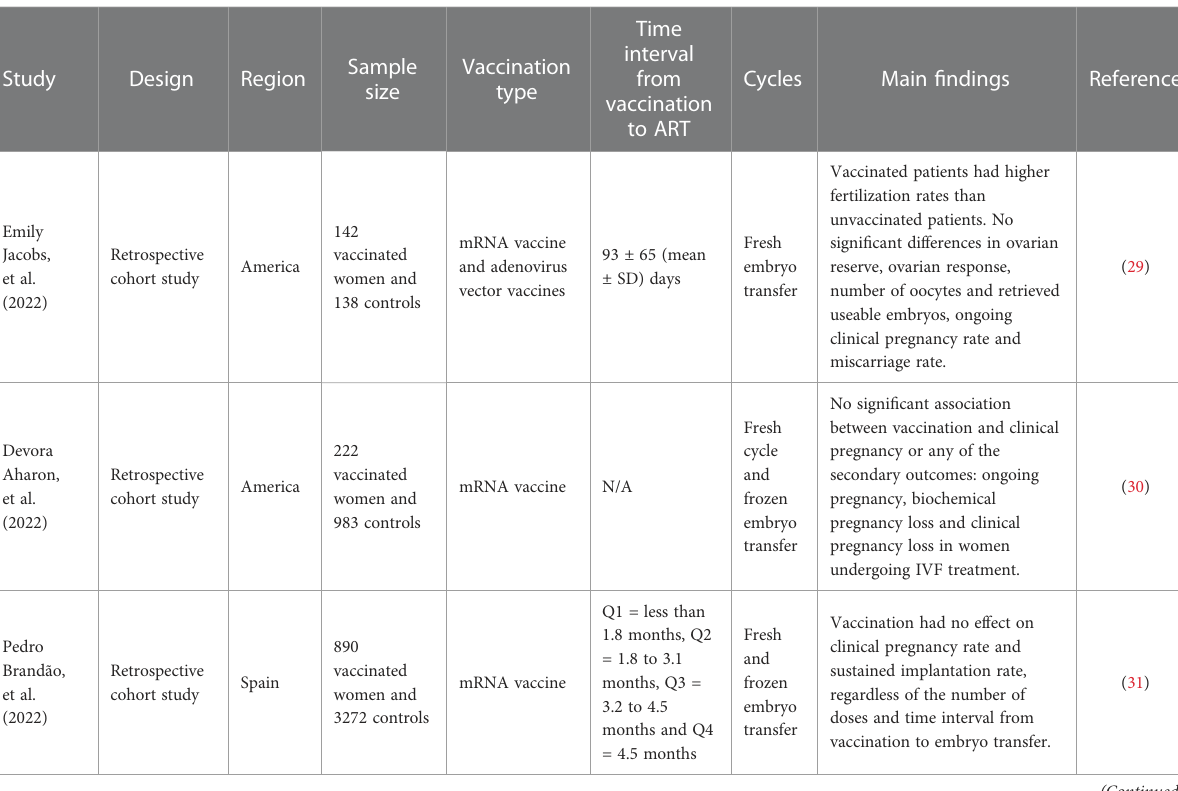
TABLE 6 Systematic review of COVID-19 vaccination studies in women undergoing IVF/ICSI treatment.